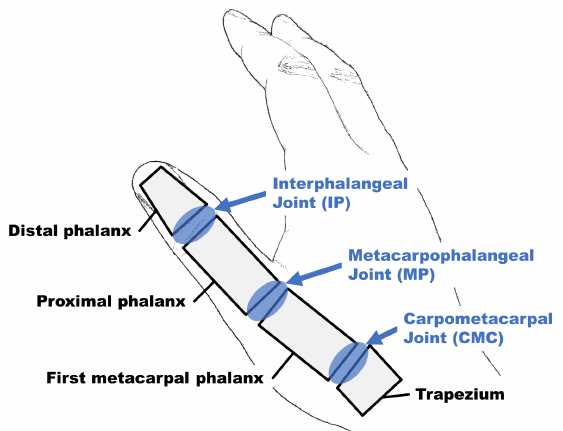
Figure 1. Joints and bones of the